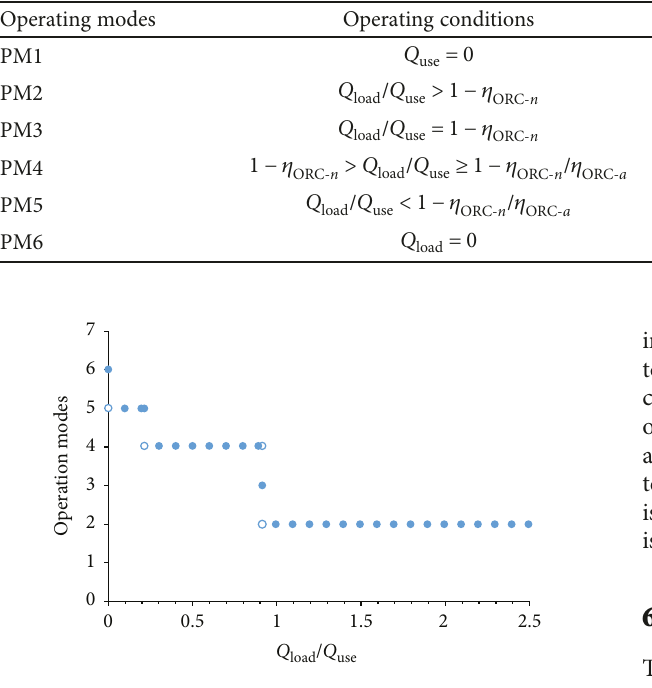
Figure 11: Operation modes of the cogeneration system at di ff erent / Q Q load use